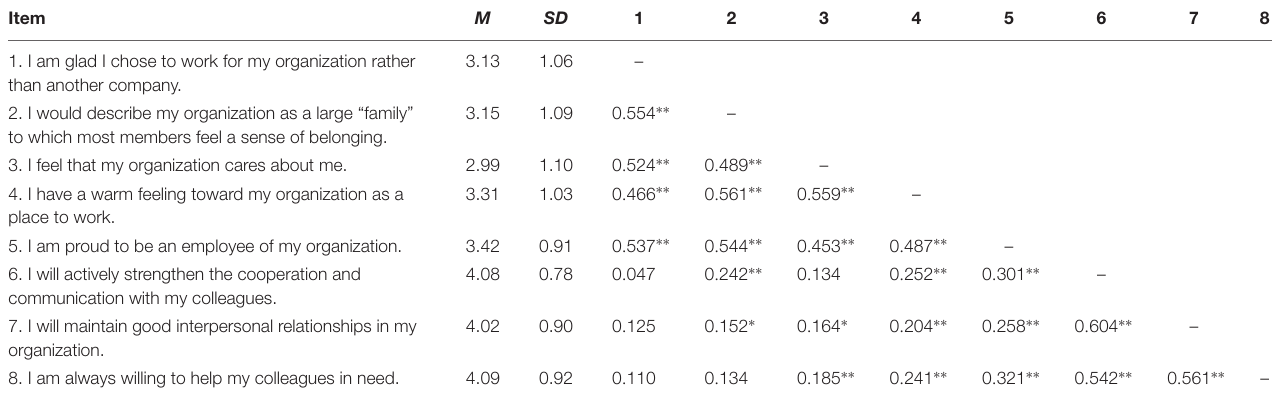
TABLE 2 | Means, standard deviations and inter-correlations of the COIQ items (Study 1, n Study 1 − EFA = 203).